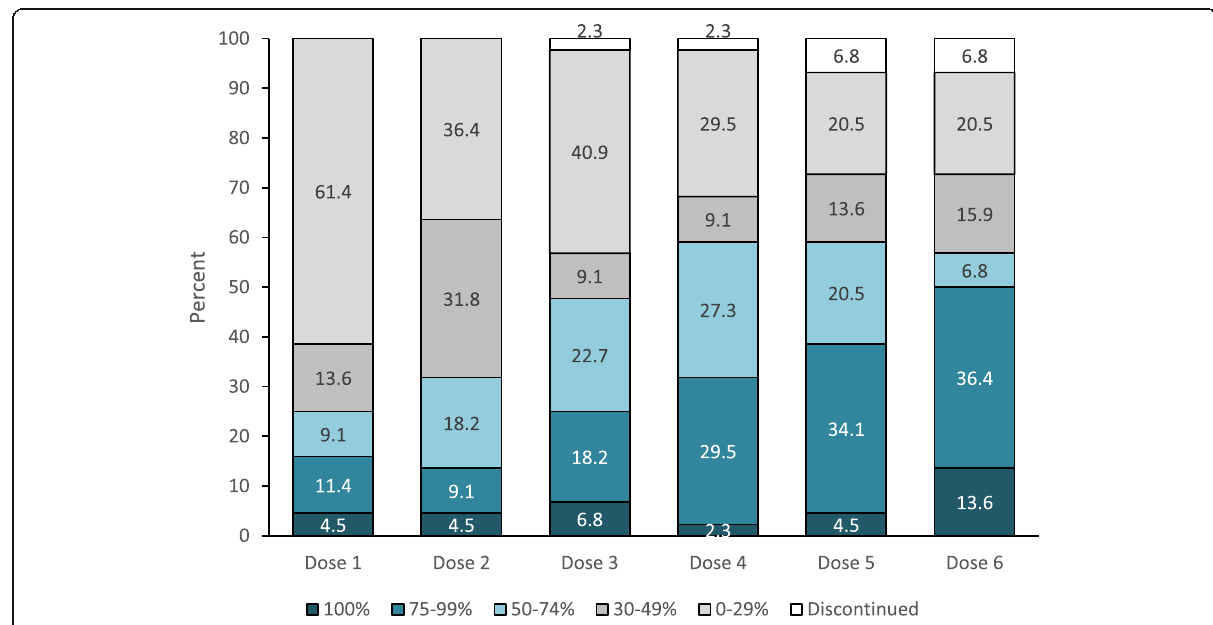
Fig. 5 Proportion of responders among patients with chronic migraine who had failed treatment with botulinum toxin A ( n = 44)